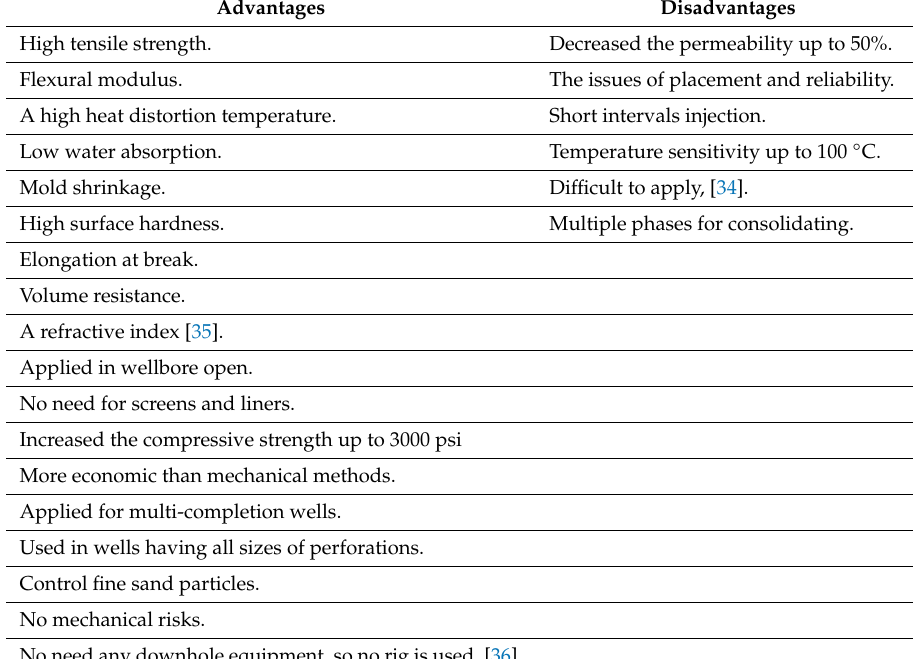
Table 2. Advantages and disadvantages of phenol-formaldehyde resin and urea-formaldehyde